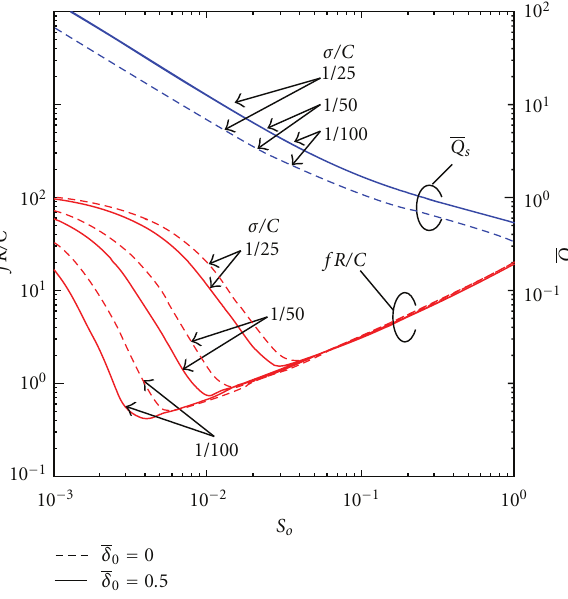
Figure 9: E ff ect of surface roughness σ / C on frictional coe ffi cient fR / C and side leakage flow rate Q S o (no dent and δ o =